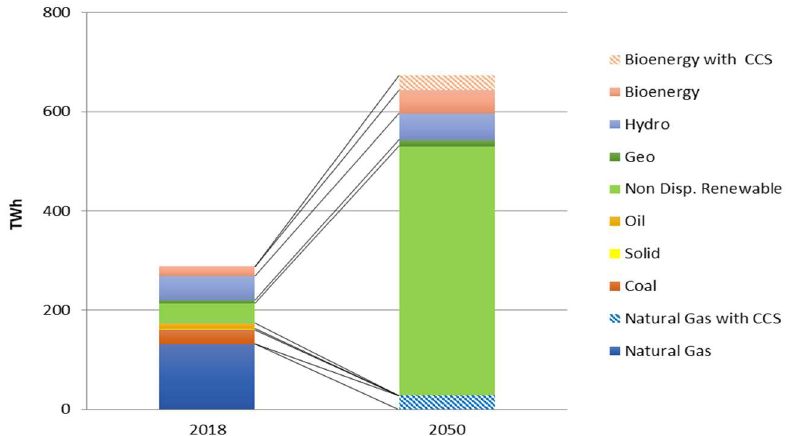
Figure 11. Expected evolution of electric energy production (TWh): comparison between the current state (2018) and the LTS 2050 decarbonization scenarios.